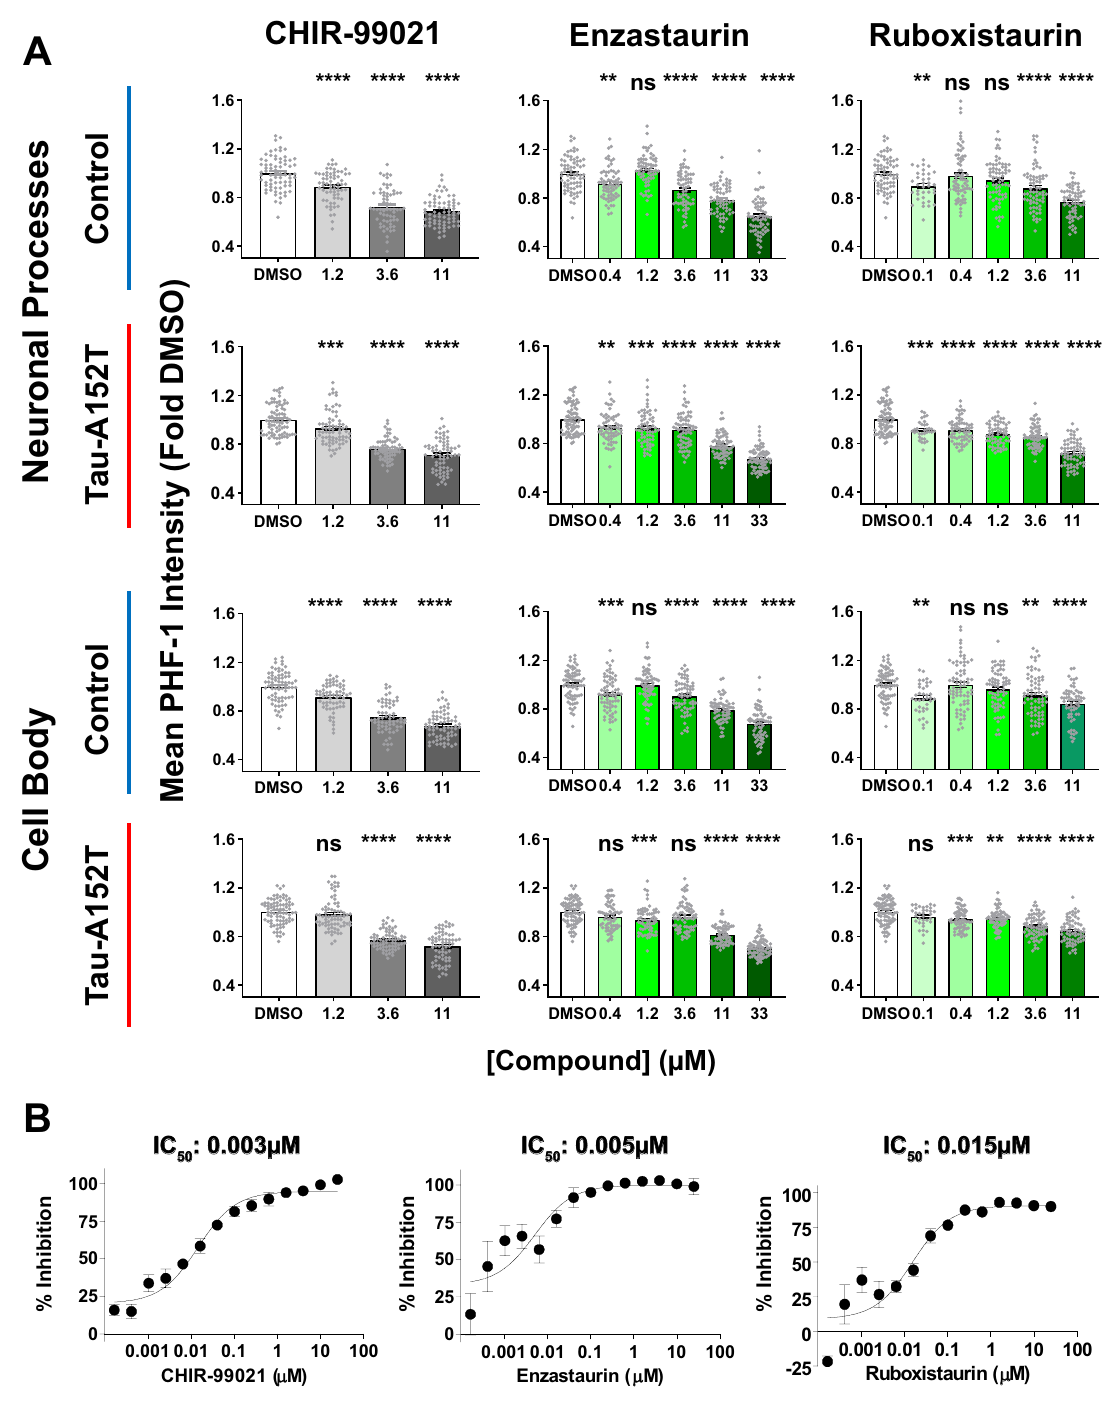
Figure 6. Dose-dependent effect of selected compounds on p-Tau in human neurons and in an in vitro GSK3β assay. ( A ) 20 h treatment with CHIR-99021, enzastaurin and ruboxistaurin dose-dependently decreased mean PHF-1 intensity in both cell bodies and neuronal processes in both control and patient iNgn2 neurons. Mean ± SEM of two biological replicates; dots represents individual values. One-way ANOVA, Dunnett’s post hoc test, ns = not significant, *p ≤ 0.05, **p ≤ 0.01, ***p ≤ 0.001, ****p ≤ 0.0001 compared to DMSO. ( B ) IC 50 values of CHIR-99021 (positive control, n = 2), enzastaurin (n = 4) and ruboxistaurin (n = 4) as determined in the ADP-Glo kinase assay for GSK3β, where n is the number of replicate